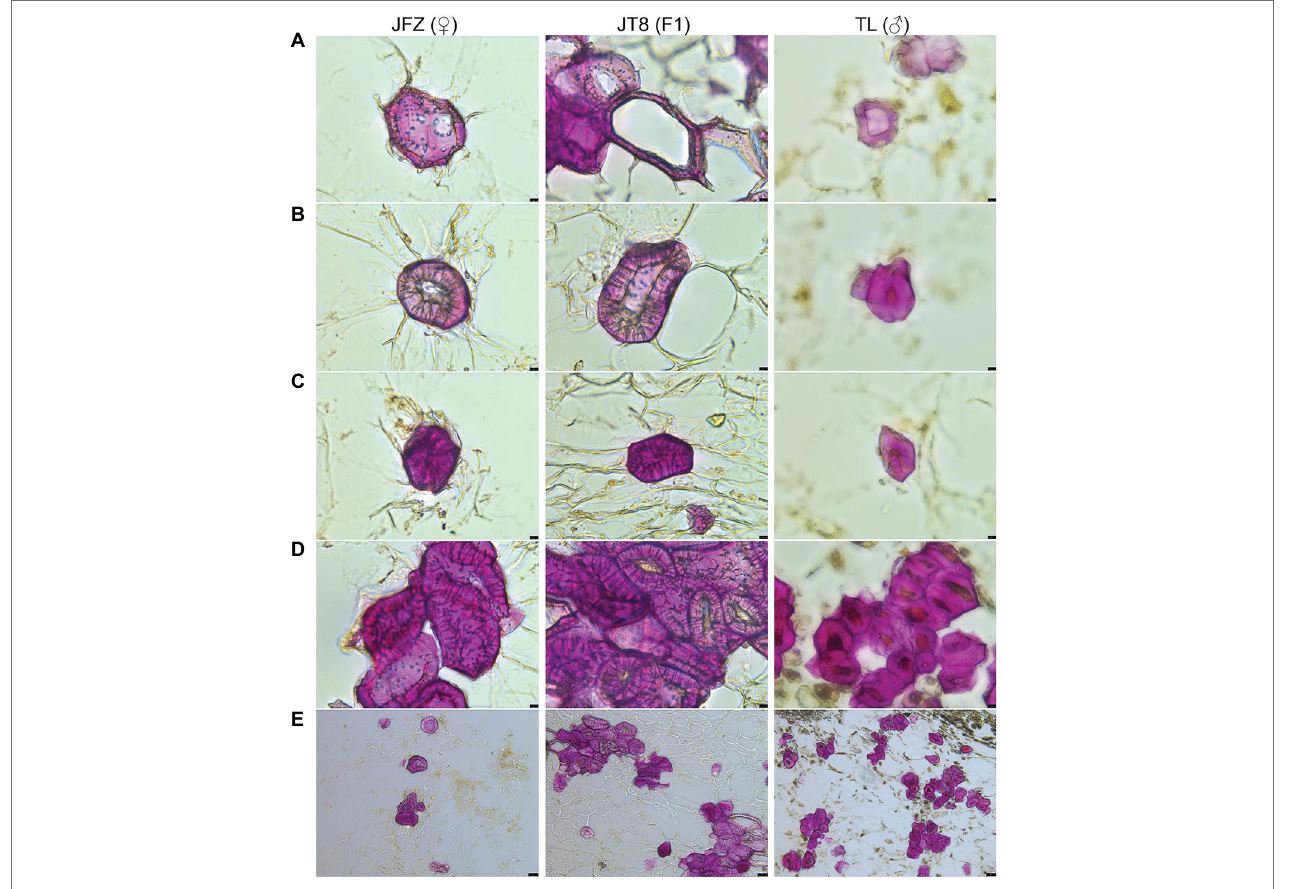
FIGURE 3 | Phloroglucinol-HCl staining and microscopic observation of freezing microtome sections of fruit pulp taken from three loquat plants at 126 DAF. (A) The secondary cell wall of sclereid primordium cells starts to thicken (400×). (B) The sclereid primordium cell shows a continuously thickened secondary cell wall and shrunken protoplasm (400×). (C) The typical stone cell is filled by secondary cell wall structures without protoplasm (400×). (D) Stone cell clusters (400×). (E) Stone cell clusters (100×). The black bar in the lower right represents 10 μ m in (A,B) and 50 μ m in (E)